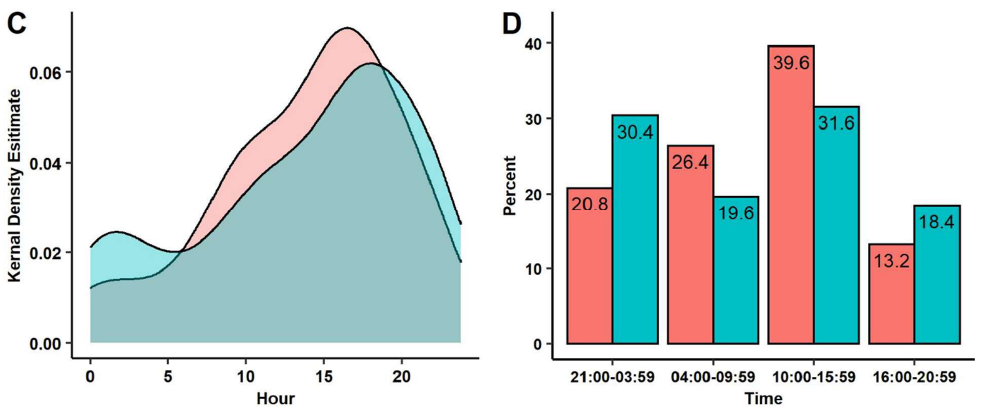
Figure 3. ( A ) A density plot depicting the distribution of arrival times for certain e-scooter patients as a function of the night time ban (12:00 a.m. is set to hour 0); the difference between the distributions was not significant ( p = 23), ( B ) A bar graph depicting the percentage of certain scooter patients as a function of time of day and night time ban, the effect of the nighttime ban was not significant ( p = 16), ( C ) A density plot depicting the distribution of arrival times for certain scooter patients transported by Emergency Medical Services (EMS) as a function of the night time ban; the difference between distributions is not significant ( p = 0.18), ( D ) A bar graph depicting the percentage of certain scooter patients transported by EMS as a function of time of day and night time ban; the effect of the nighttime ban was not significant ( p = 32).